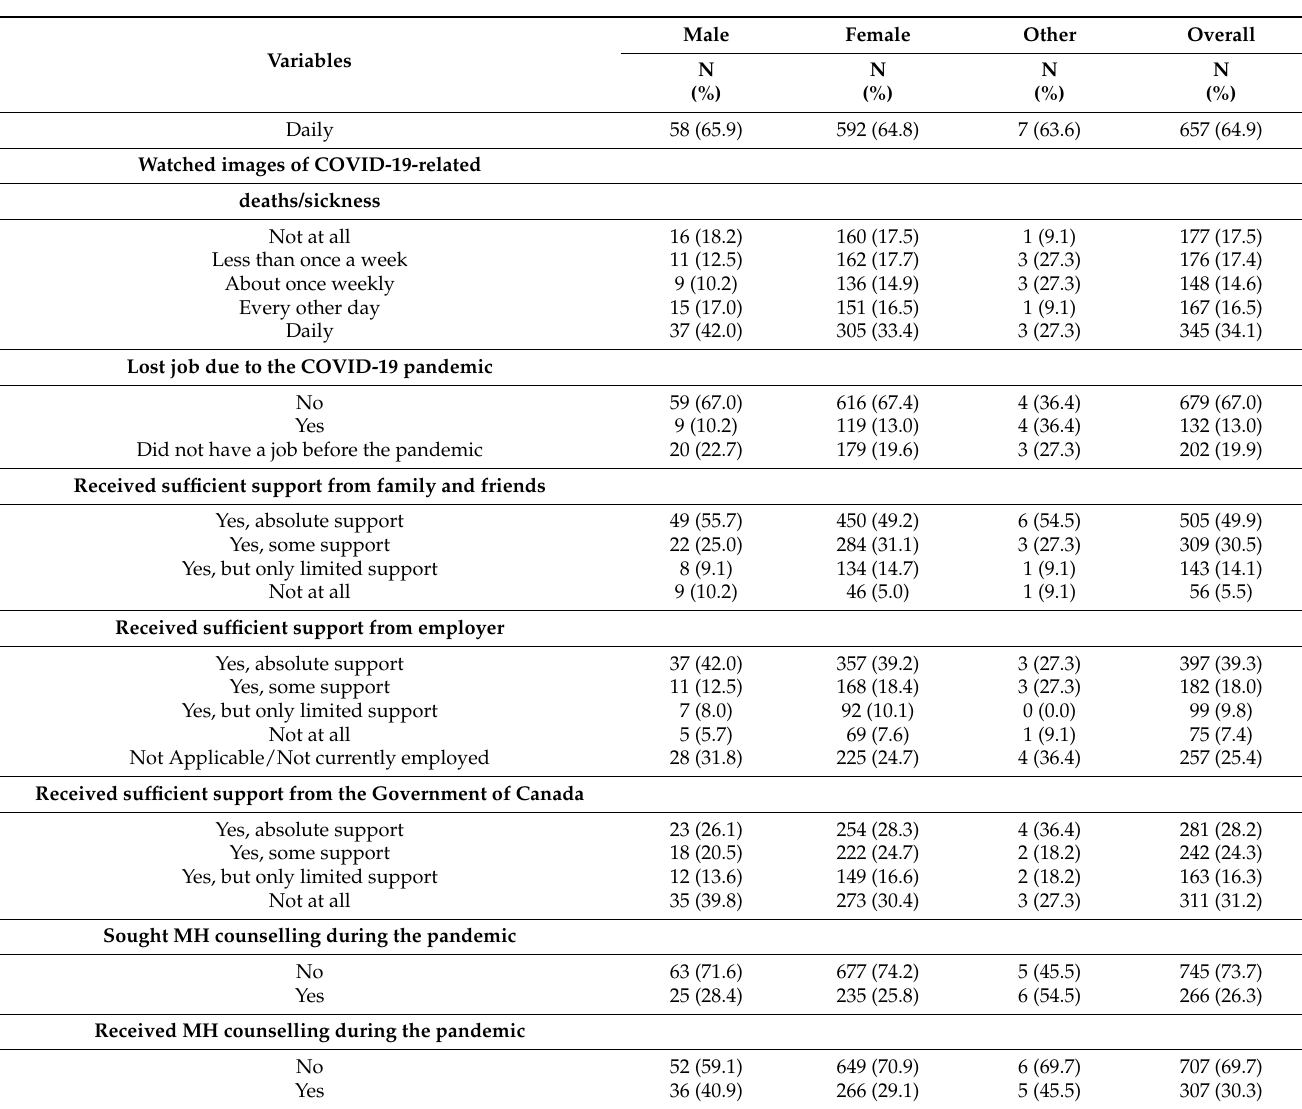
Table 2 indicates that just over half of the respondents reported having no history of any mental health disorder (51.3%), while almost a third reported having a history of either anxiety or depressive disorder (31.2% and 30.8%, respectively), with the highest prevalence observed among other gender for the two conditions. Respondents who reported receiv- ing antidepressant medications before the pandemic represented the highest proportion (28.2%), compared to respondents who reported use of other psychotropic medications (<10%). Again, other gender had the highest rates of receiving all psychotropic medications except for mood stabilizers, where males reported the highest intake rate (15.6%). Self-isolation or self-quarantine was reported by around 1 in 4 respondents (26.4%), and around 1 in 12 (7.9%) reported having a family member or friend test positive for coronavirus. More than 8 in 10 respondents were afraid of being infected (83.2%). Finally, almost a half of the respondents scored positive for the likelihood of PTSD based on the PCL-5 scale (46.8%), with other gender reporting the highest prevalence